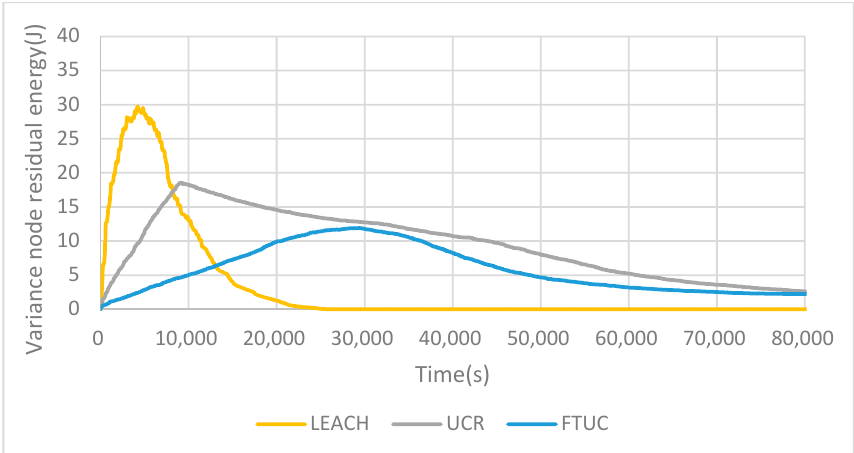
Figure 13. Variance of residual energy for each network. FTUC enables one to have a better repartition over time, increasing the network lifetime.